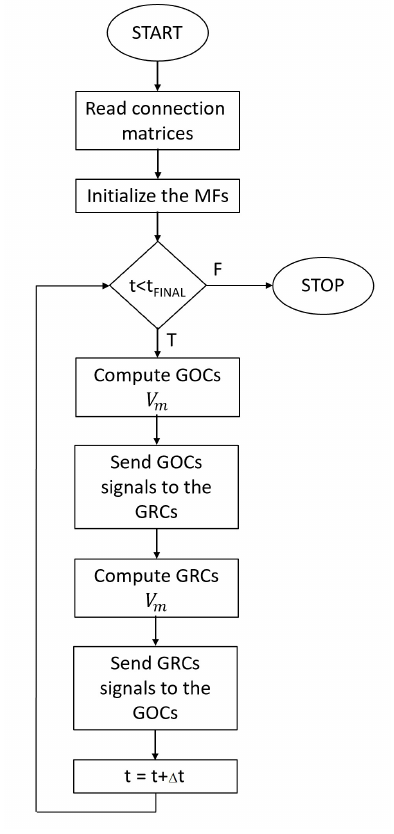
Figure 4. The flowchart of the serial network